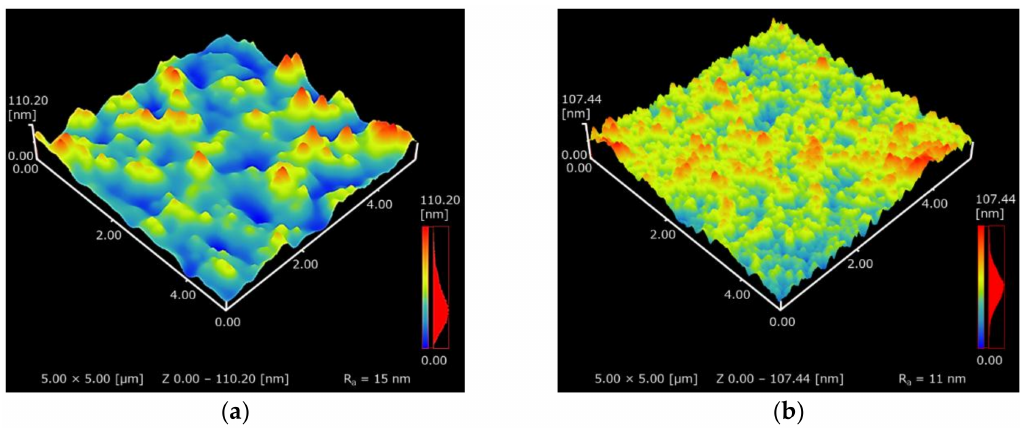
Figure 2. 3D atomic force microscopy (AFM) images of F” edta ( a ) and F” mix ( b ).